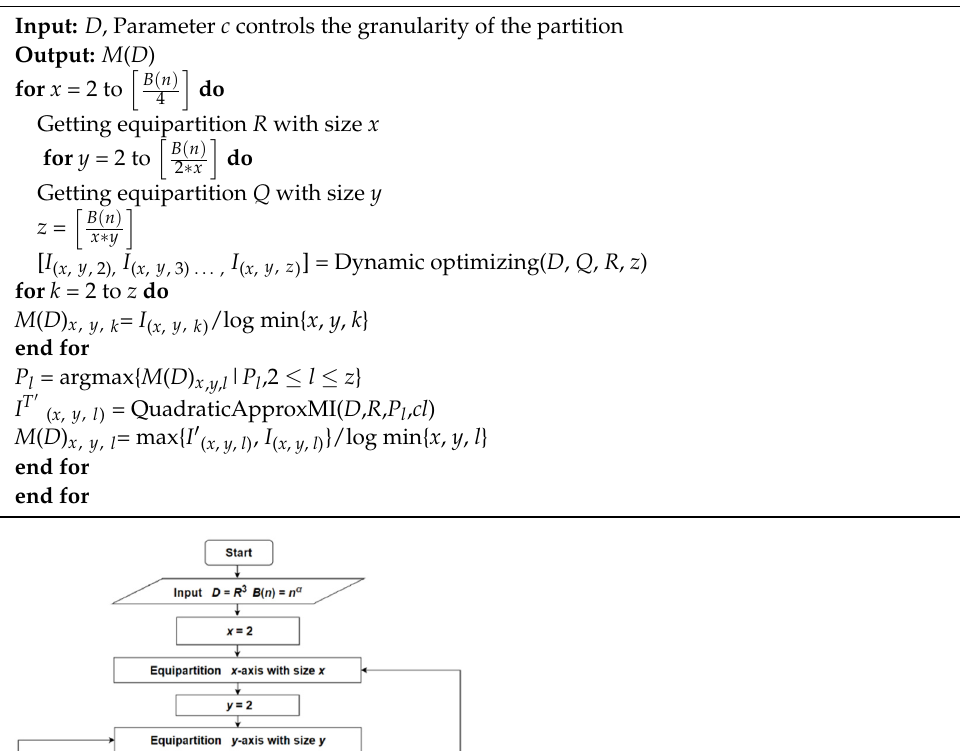
Algorithm 1: Generating trivariate characteristic matrix.